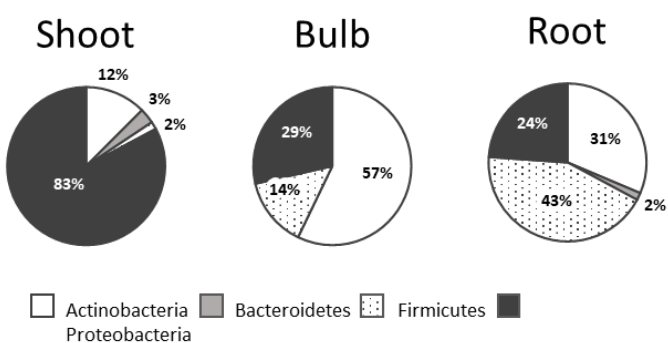
Figure 4. Relative abundance of each phylum in the bacterial collection of the different plant tissues.